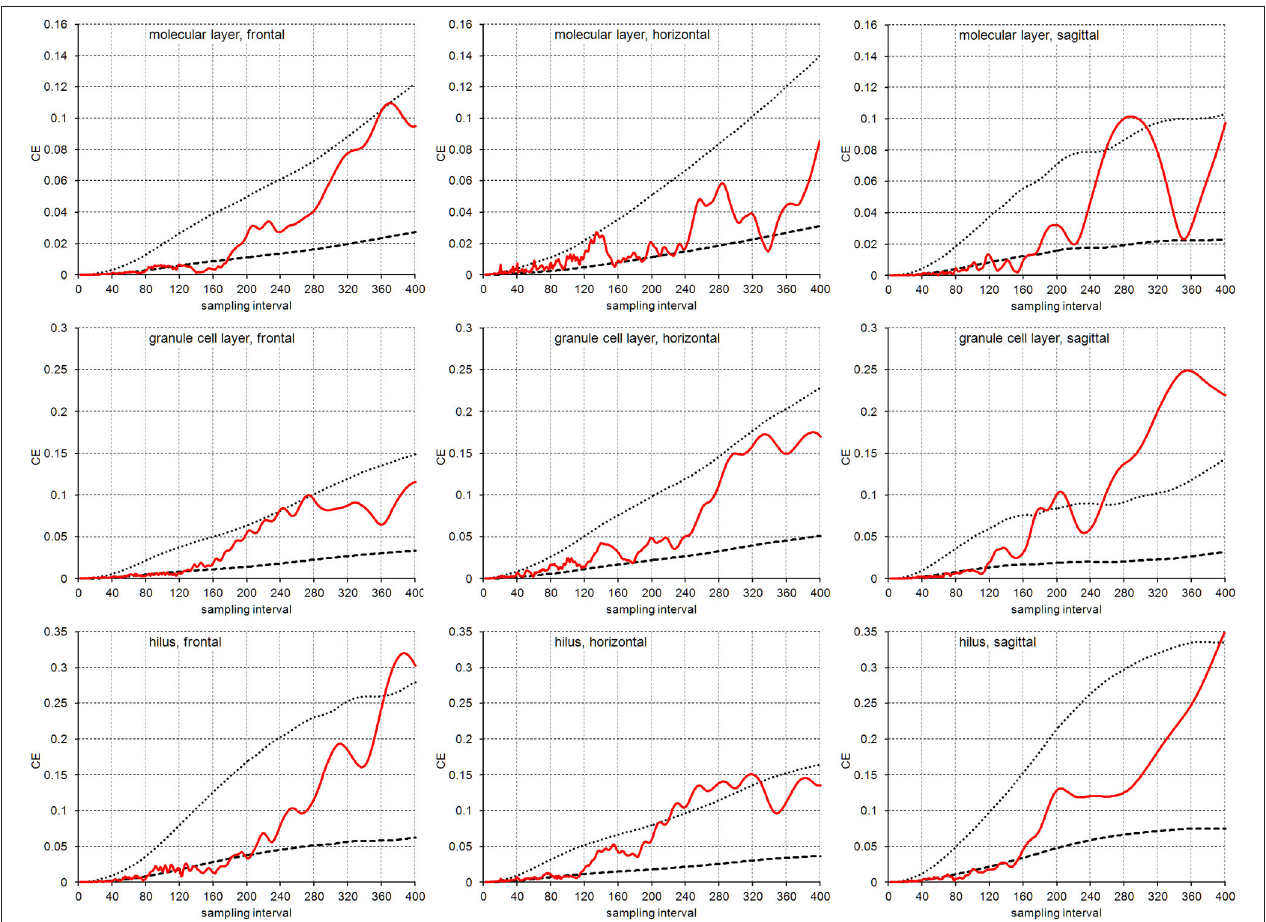
FIGURE 5 | CE estimates based on virtual sectioning of 3D models . Empirical CE estimates (solid lines) are typically bounded by the means of the Gundersen-Jensen CE estimates for m 0 (dotted lines) and m 1 (broken lines) and exceed CE estimates for sampling intervals that correspond to the distance between peaks in the = = volume distributions ( Figure 2 ). The very intense sampling (1 µ m sections) and higher subsample numbers for low sampling intervals show transitions in the behavior of the empirical CE from following an m 1 at low sampling intervals to an m 0 at high sampling intervals. In addition, empirical CE s now oscillate with increasing = = amplitude and period for increasing sampling intervals (Zitterbewegung; best seen in the frontally sectioned